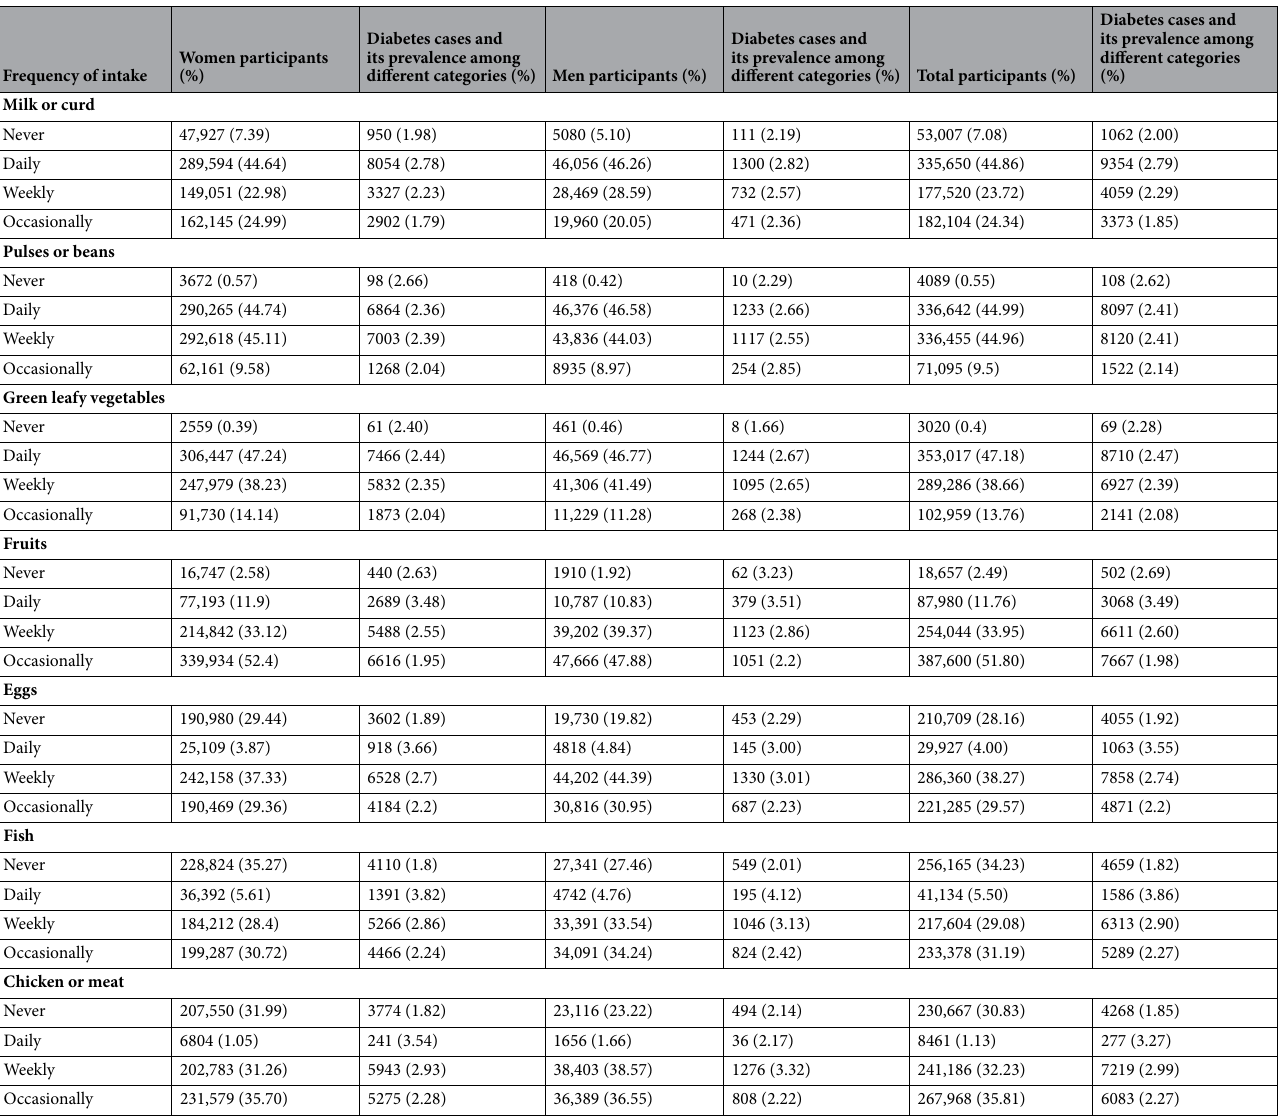
Table 2. Sample distribution and prevalence of diabetes among women and men of age group 15–49 years as per frequency of intake of food items in National Family Health Survey, 2015–2016. All the values are weighted using sample survey weights from